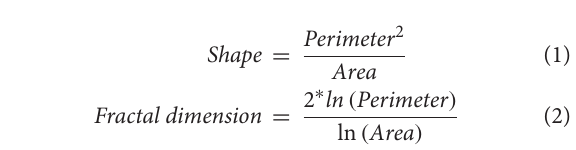
Frontiers in Environmental Science |